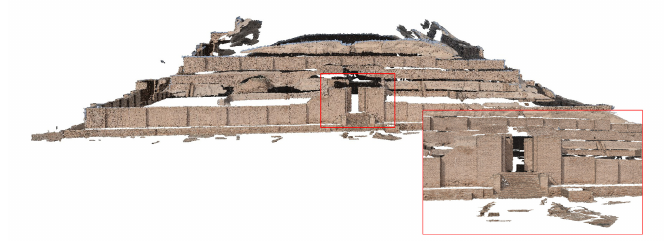
Figure 14. Facade view of the GB cloud with an aspect to the details of the cloud.